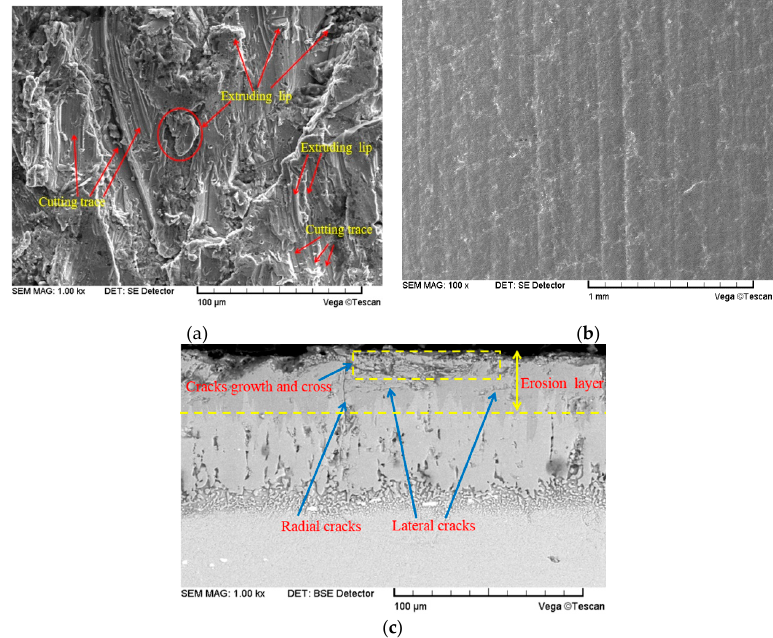
Figure 10. Erosion morphology of the target surface at 210 m/s, 566 ℃ and 30° condition (D 32 = 226 μ m): ( a ) Surface morphology of the substrate ( b ) Surface morphology of the boronized coating; ( c )